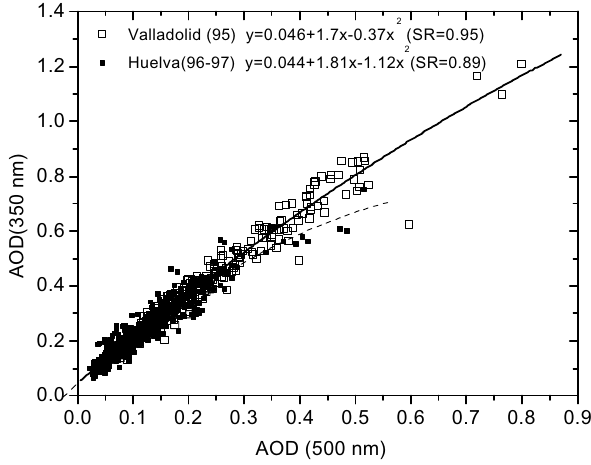
Fig. 5. Plot of the AOD at 350nm versus the AOD at 500nm for the data of the north central station of Valladolid (open square points) and those of the southwest station of “El Arenosillo”- Huelva (solid squares). Each set of data has been fitted by a polynomial expres- sion (in parenthesis the square of the correlation